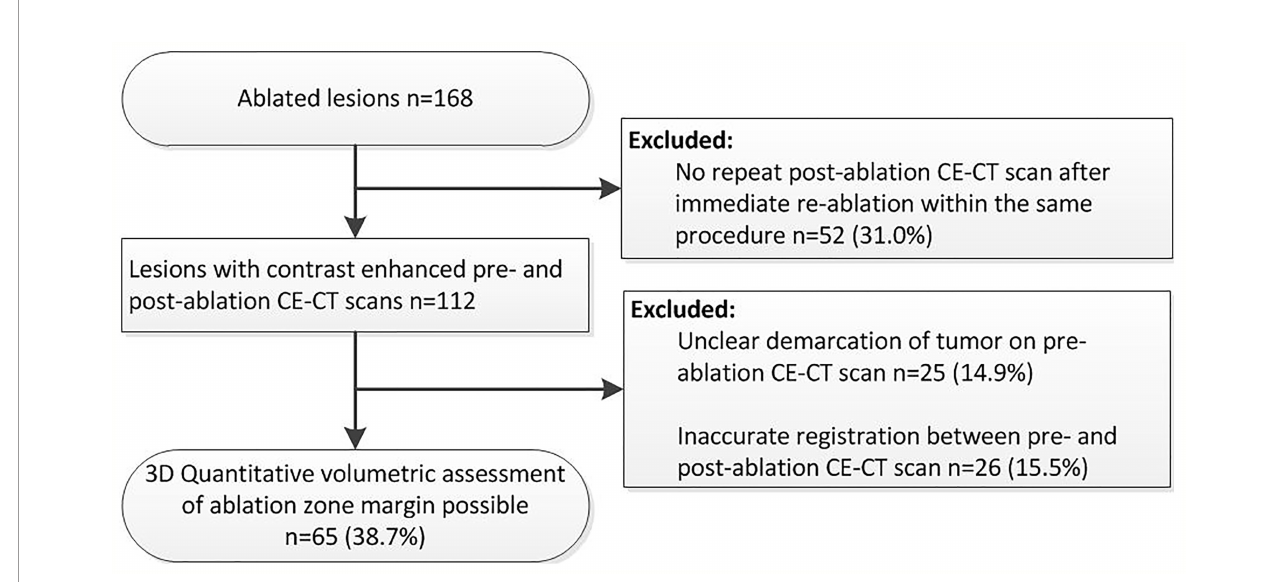
FIGURE 1 | Flowchart of retrospective inclusion of tumors for three-dimensional quantitative ablation margin (3D-QAM)